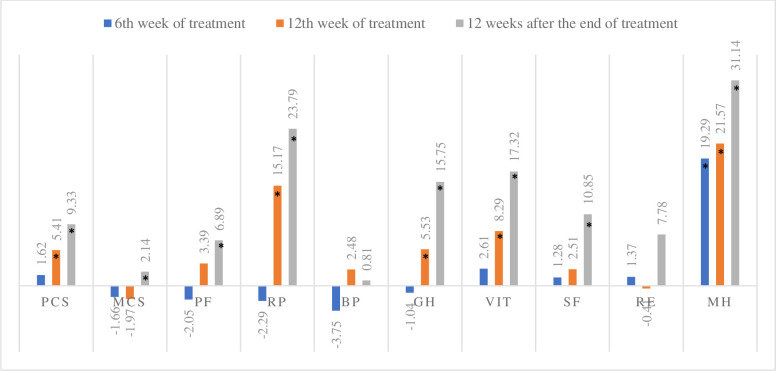
Difference of the mean score in relation to the SF-36 baseline.Analysis of Student t test to compare the means of week 6 of treatment, week 12 of treatment and 12 weeks after the end of treatment in relation to the baseline scores, * p <0.05. N = 105. PCS, Physical Component Summary; MSC, Mental Summary Component; PF, physical functioning; RP, role physical; BP, bodily pain; GH, general health; VIT, vitality; SF, social functioning; RE, role emotional; MH, mental health.